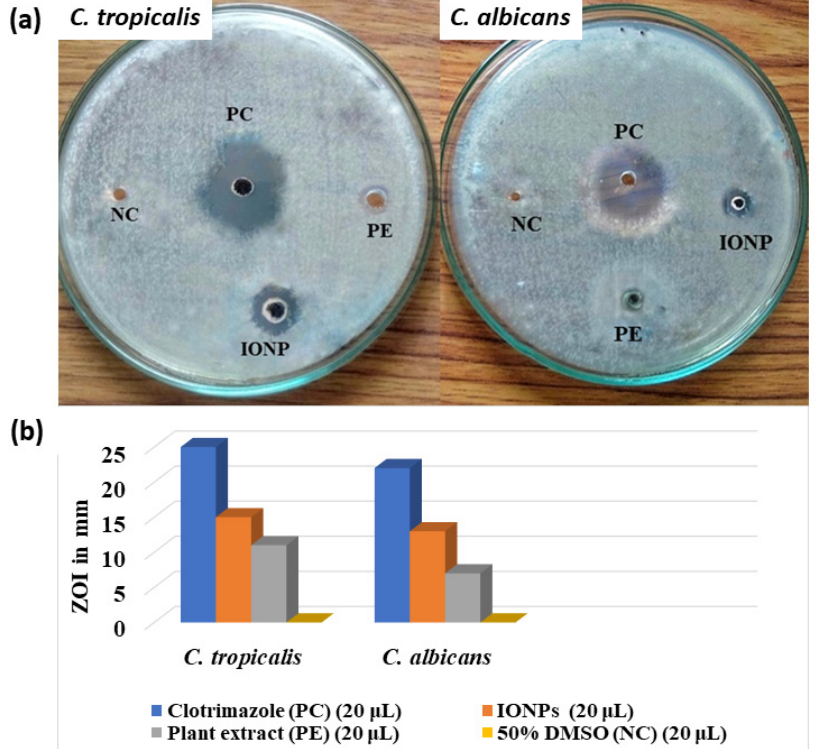
Figure 8. ( a ) Anti-fungal activity of IONPs against C. tropicalis and C. albicans and ( b ) Comparative graphical representation of fungicidal inhibition zone of IONPs on different fungal strains.